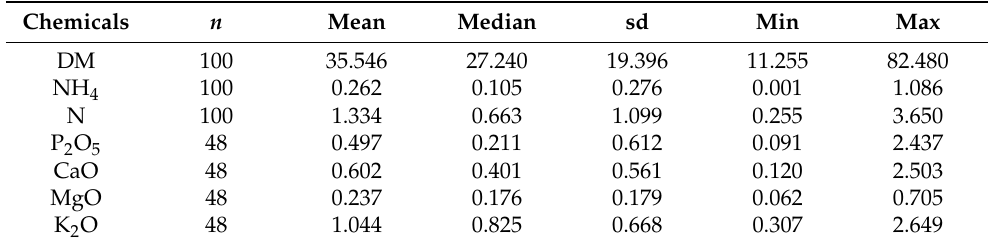
Table 3. Descriptive statistics of the chemical components of poultry and cattle manure in fresh- weight basis (%) of the 100 (for dry matter (DM), total ammonium nitrogen (NH 4 ), and total nitrogen (N)) and 48 (for P 2 O 5 , Cao, MgO, and K 2 O) samples for the test set, which are then set aside for the final arbitration on the performance of the different models. ( n = number of samples, sd = standard deviation, min = minimum value, max = maximum